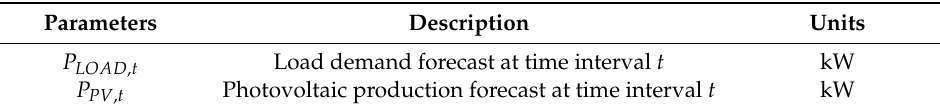
Table 7. List of parameters in the MIP